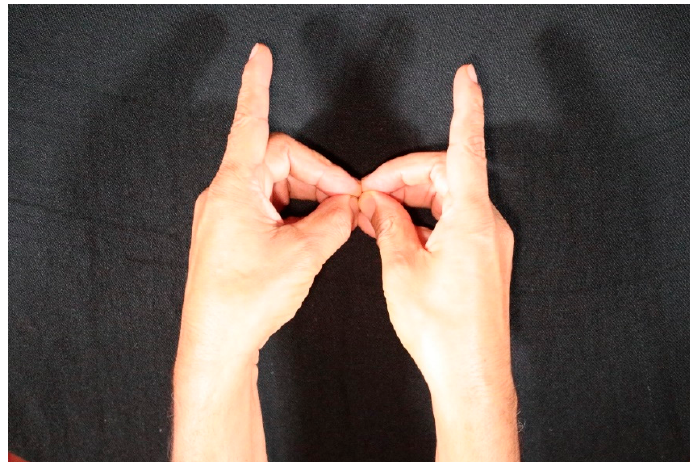
Figure 2. Samk ṣ obhi ṇ ī -Mudr ā . Figure 2. Samks.obhin.¯ı-Mudr¯a.